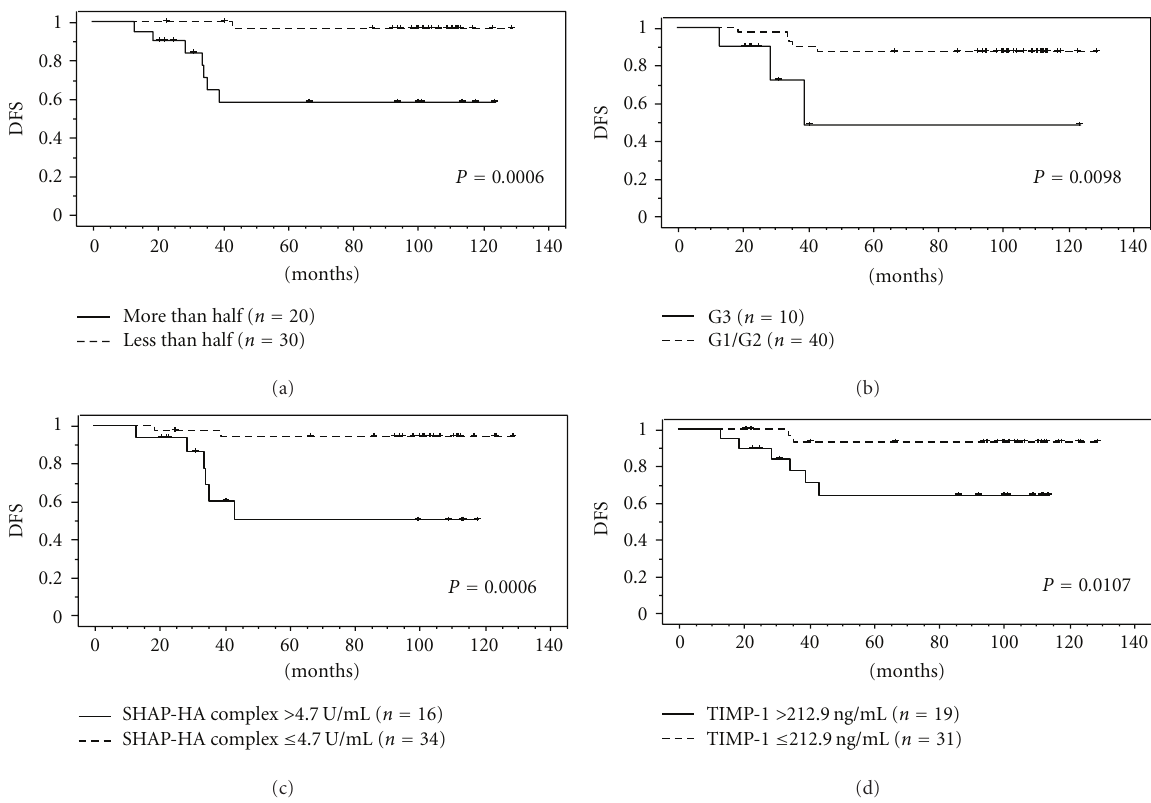
Figure 2: Disease-free survival in endometrial cancer patients was analyzed by the Kaplan-Meier method and log-rank test. The patients with the deeper myometrial invasion, poorly di ff erentiated tumor, elevated serum level of the SHAP-HA complex, and elevated serum level of TIMP-1 had a significantlyshorter disease-free survival. The maximalnormal level in serum of the SHAP-HA complex in serum was deter- mined as 4.7 U/mL for the SHAP-HA complex and as 212.9ng/mL for TIMP-1, which were a value of the mean + 2SD in 50 healthy women.